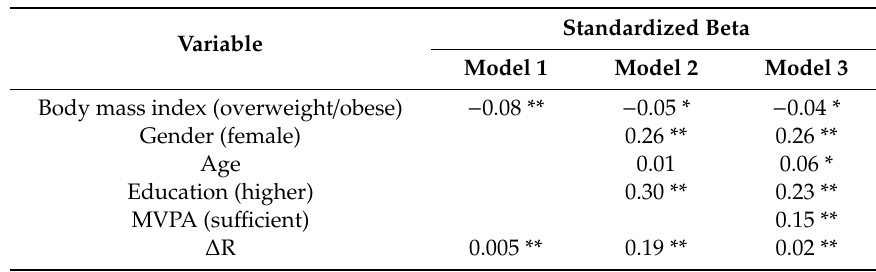
Table 2. Predictors of better adherence to a Mediterranean diet among Lithuanian young adults aged 18–36 years old (hierarchical linear